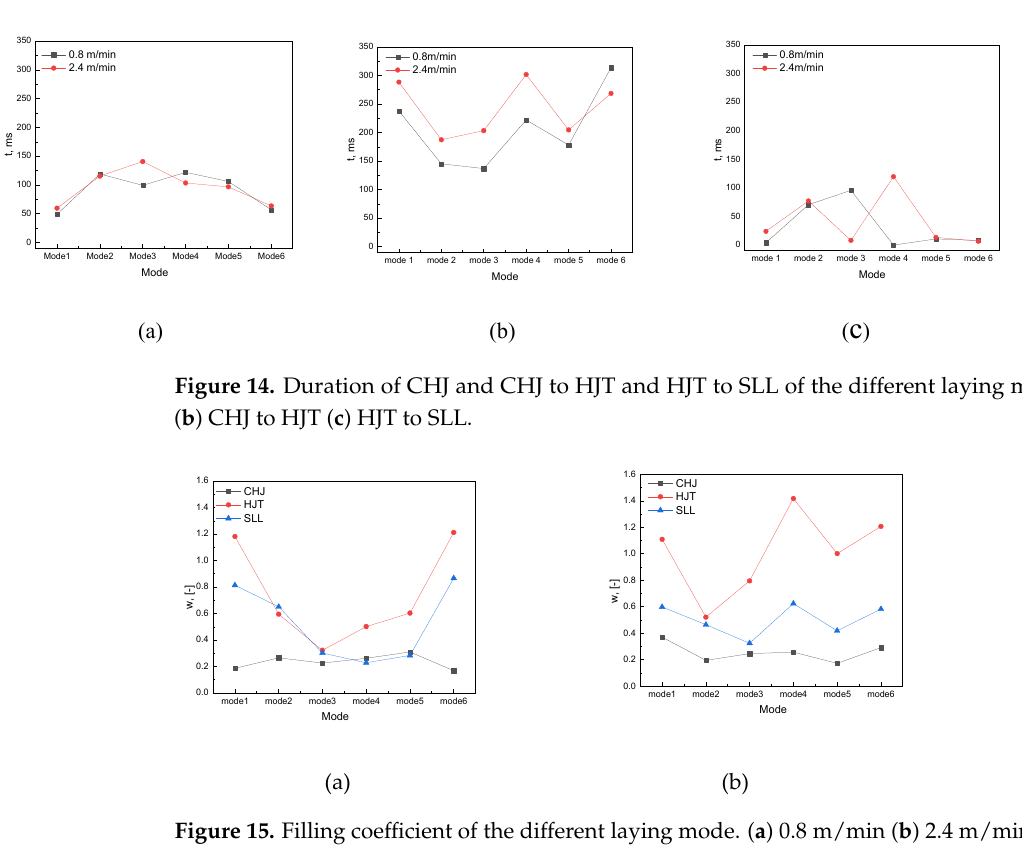
Figure 15. Filling coefficient of the different laying mode. ( a ) 0.8m/min ( b ) 2.4m/min. The spring and particles arrangement of different modes in the three hydraulic jump forms and changes of arrangement as the liquid level rises after impacted by the jet under the casting speed of 0.8 m/min are shown in Figure 6 (top view, the particles are all in one layer). The distribution of particles can characterize the flow field, which is driven by the hydraulic jump formed after the impact of the jet; and it develops with the flow to the wall. The black area here in the mold center is the surface flow zone (one typical feature of the circular hydraulic jump forms, the surface flow boundary can be characterized by particles). After the impact by the jet, the springs and particles leave the center of the mold and move to the sidewall. The details are as follows: Modes 1 and 6: The surface flow is affected by the initial arrangement and the wall of the mold. The hydraulic jump develops more quickly than others, the restraint of the spring arrangement for the hydraulic jump is the smallest. Modes 2 and 3: the initial spring arrangement looks unchanged, the flow is restricted strictly by the initial spring arrangement in CHJ and HJT. The packing morphology of the particles indicates the occurrence of a circular hydraulic jump with a circular At a low casting speed of 0.8 m/min: w of modes 1 and 6 in CHJ is different from that of the other two forms (HJT and SLL); and w of modes 2–5 has similar laws in the three forms (CHJ, HJT, and SLL). w of modes 3–5 is small in CHJ and SLL, w of mode 2, 4, and 5 increases significantly in HJT. At a high casting speed of 2.4 m/min: the law of w in the three forms basically obeys the mode (arrangement). w of modes 1, 4, and 6 is large, while w of modes 2, 3, and 5 is relatively small. In general, w is the largest at HJT, followed by SLL, and CHJ is the smallest. w is small for closely arranged modes, while w increases for loosely and unstable modes; the change of w in CHJ is smaller than that in HJT and SLL for all modes. The different spring